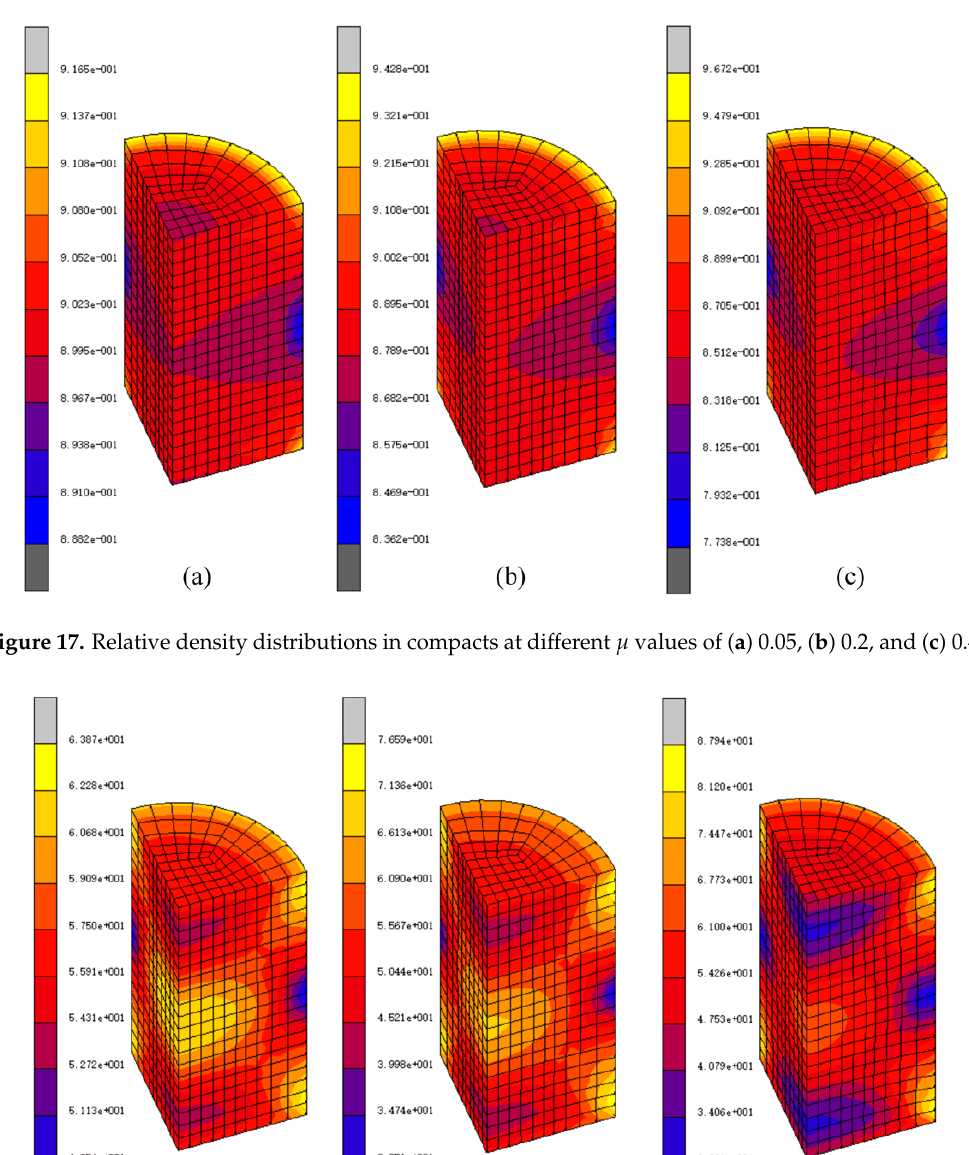
Figure 19. Axial displacement distribution in powder compact at μ = 0.05 in ( a ) displacement contours and ( b ) displacement at different compact heights.